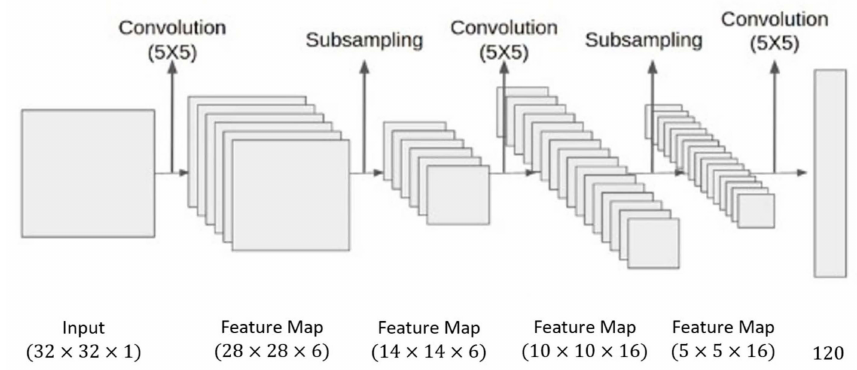
Figure 3. LeNet-5 architecture.